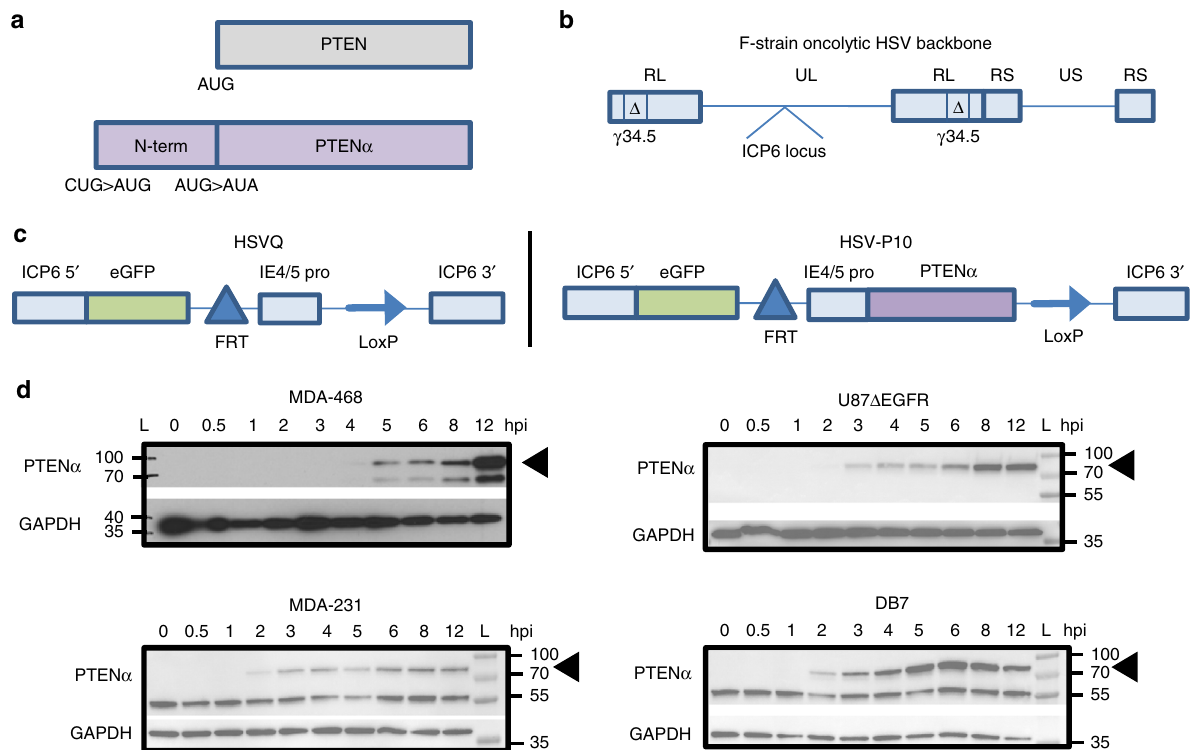
Fig. 1 HSV-P10 construction and characterization. a Graphical representation of PTEN and PTEN α coding sequences showing the mutations engineered in PTEN α start codons to enhance translation of full-length PTEN α . b – c Graphical representation of the DNA structure of wild-type F-strain HSV1 backbone showing doubly deleted γ 34.5 genes, and gene-disrupting insertional ICP6 locus containing an enhanced green fl uorescent protein (eGFP) gene with PTEN α insertion (HSV-P10) or without PTEN α (HSVQ). d PTEN α production in infected tumor cell lysates over time. The indicated tumor cells were infected with HSV-P10 at MOI = 0.5 and harvested 0 – 12 hpi and probed for PTEN by western